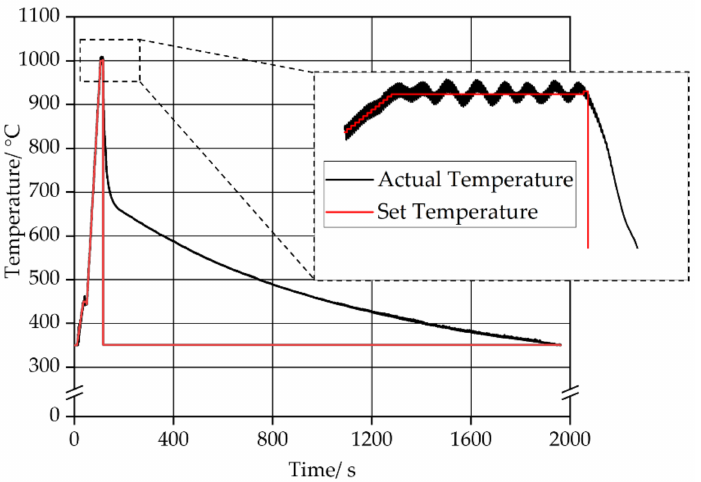
Figure 5. Example of a measured temperature curve, holding for 10 s at 1000 ◦